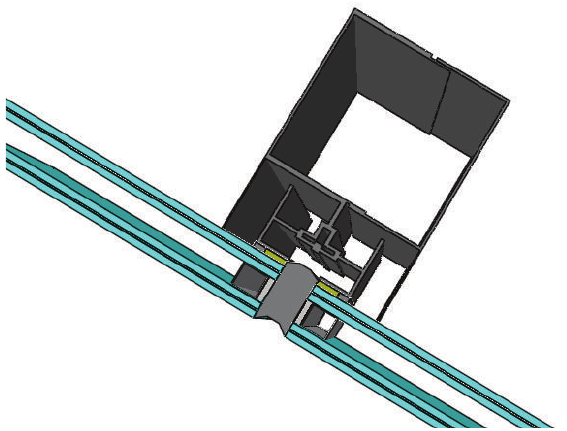
Figure 7: Detail of a facade system using laminated